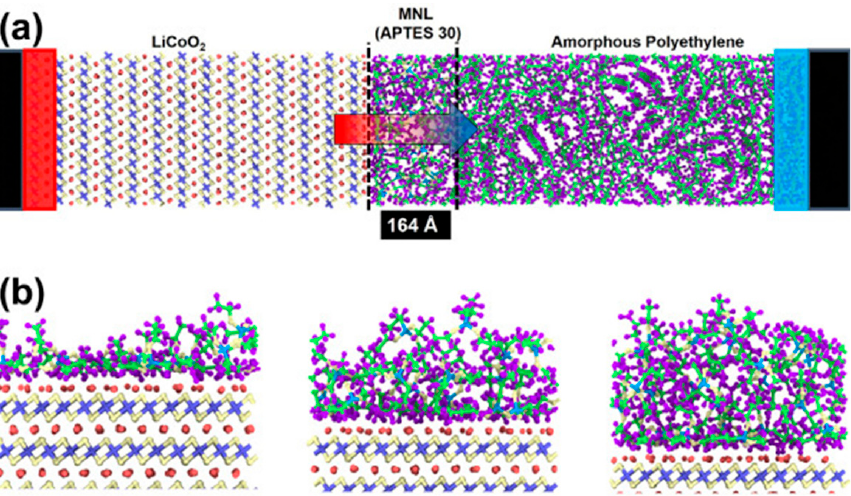
Figure 7. Representative images of the molecular assembly from Dhakane et al. [48]. ( a ) Molecular structure for simulation of a case with a bridging molecular layer (30 APTES molecules) at the LiCoO 2 -polyethylene interface. Hot reservoir (red rectangle on the left) and cold reservoir (blue rectangle on the right) maintained at 350 K and 250 K respectively are shown. ( b ) Schematics of the cathode-APTES interface for simulations with 10, 20, and 30